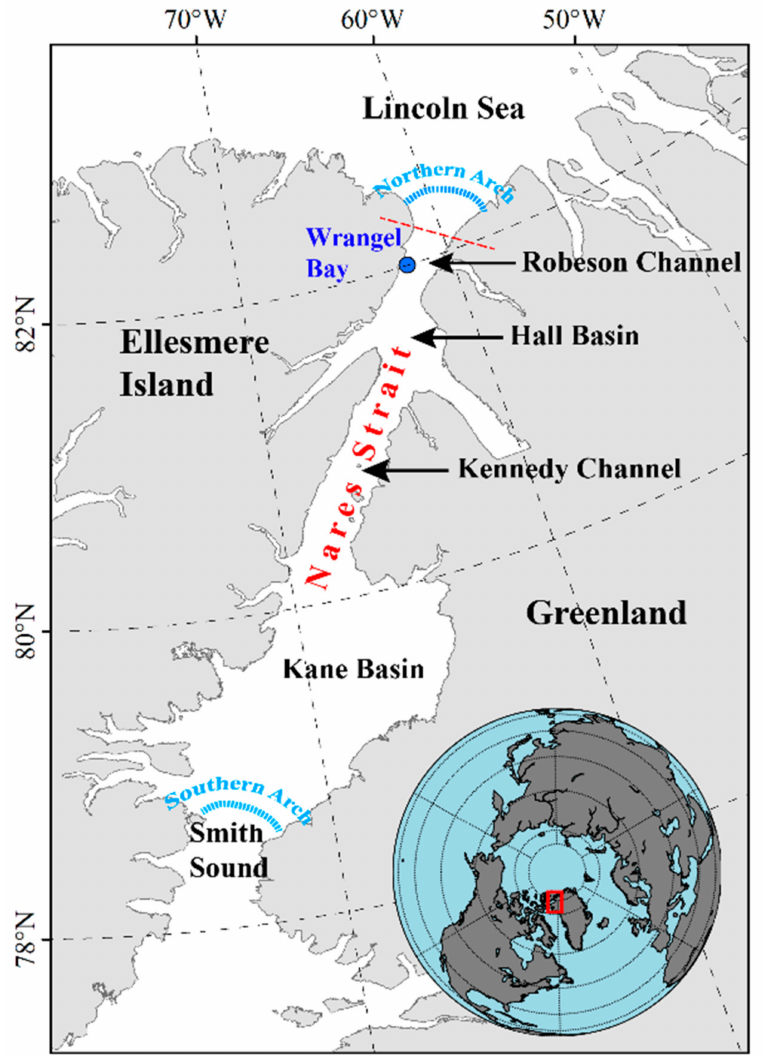
Figure 1. Geographical location of the Robeson Channel. The blue dot denotes the location of the Wrangel Bay tide station where tide gauge data are collected, the blue dotted lines denote the general locations of the northern and southern ice arches that form in some winters, and the red dotted line denotes the gate of the Robeson